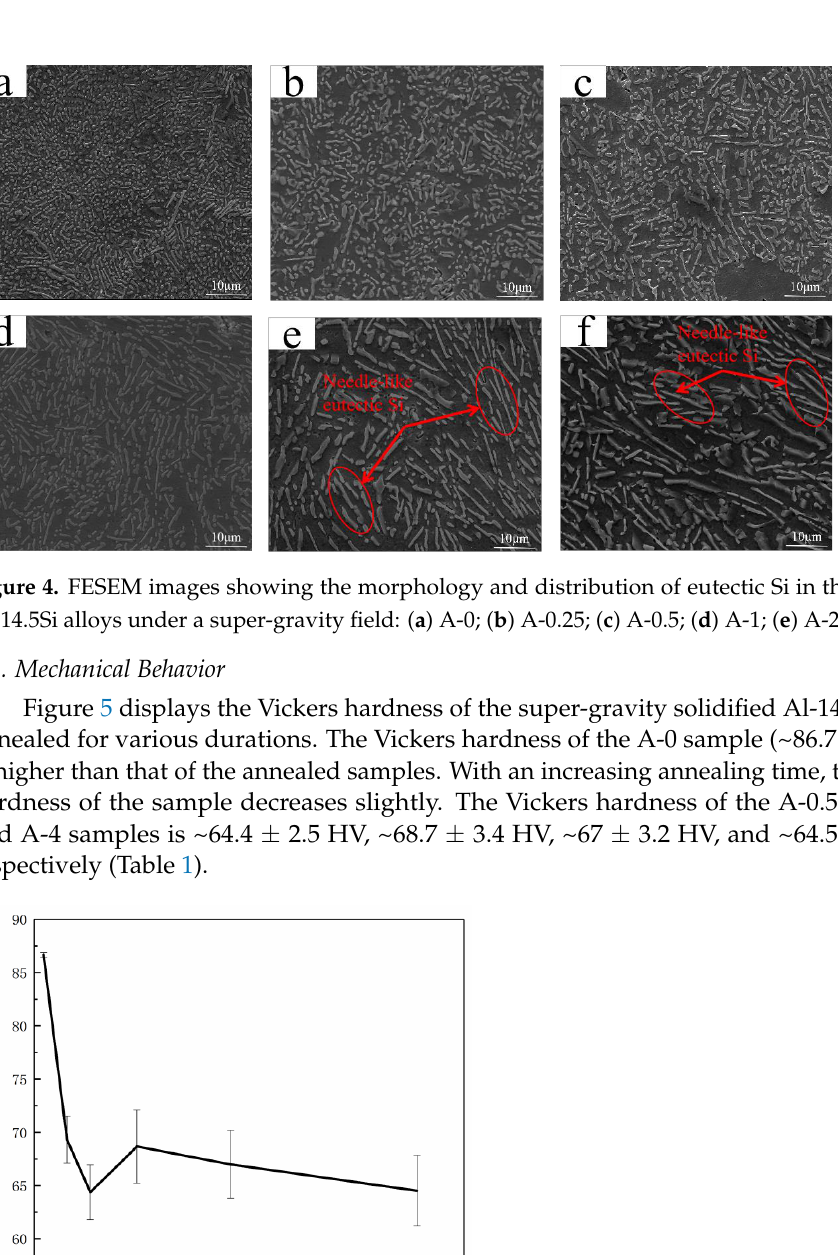
Figure 6. Tensile stress – strain curve of the annealed Al-14.5Si alloys solidified under a super-gravity field. 3.3. Fractography Figure 7 shows the typical fracture surface of annealed Al-Si alloys (produced by a tensile test). A typical ductile transgranular fracture was found on the fracture surface, as